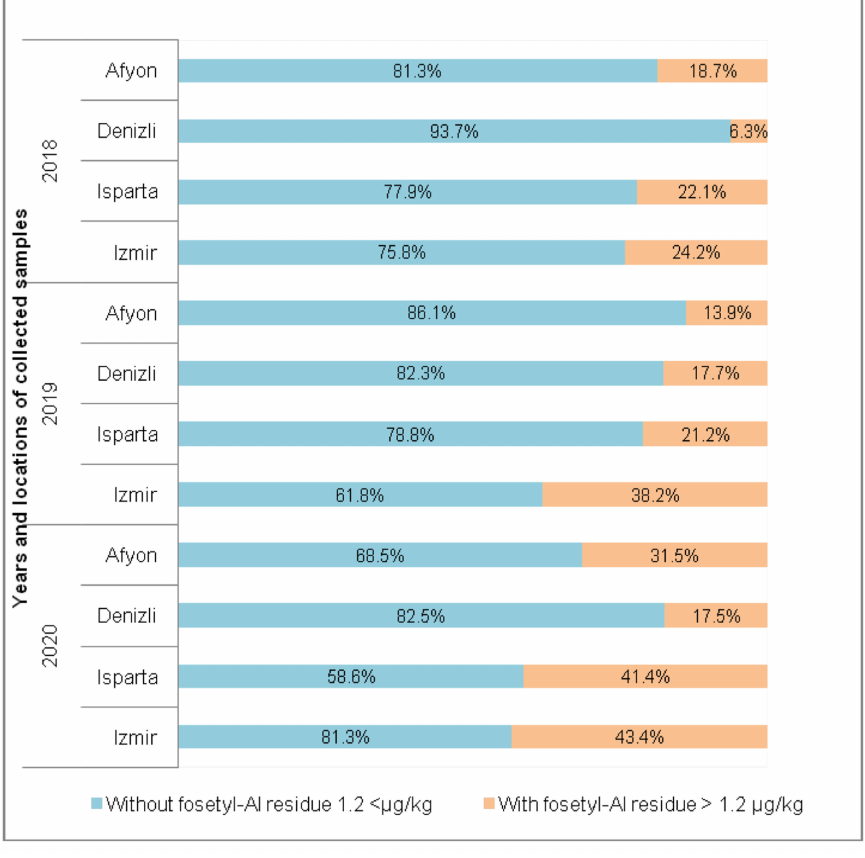
Figure 1. The frequency of cherry samples with fosetyl-Al per production area and harvest year.